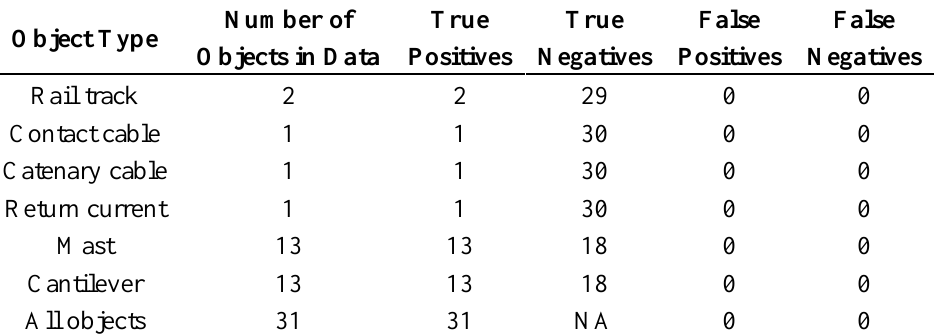
Table 3. Results at object level in terms of the number of recognized